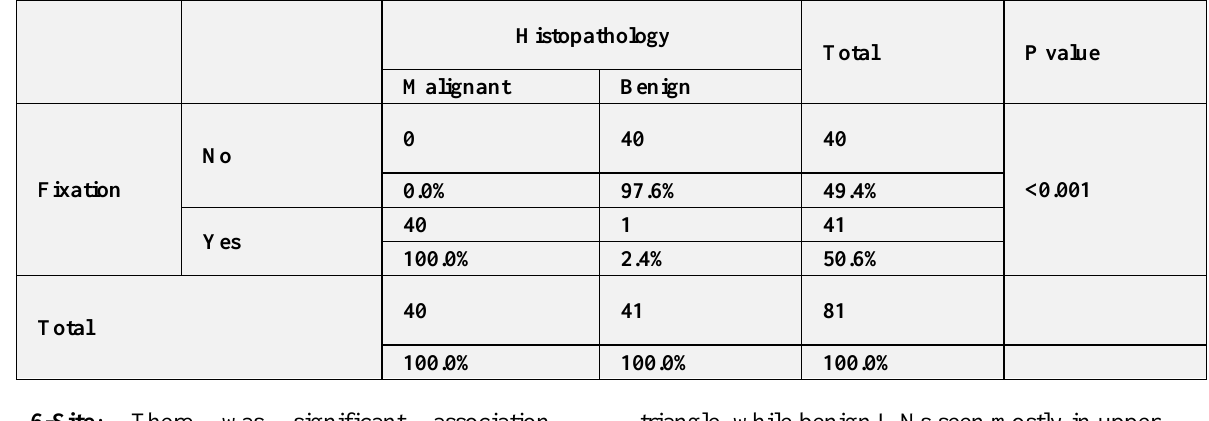
Table (5): Association between fixation of L.Ns and histopathological findings.